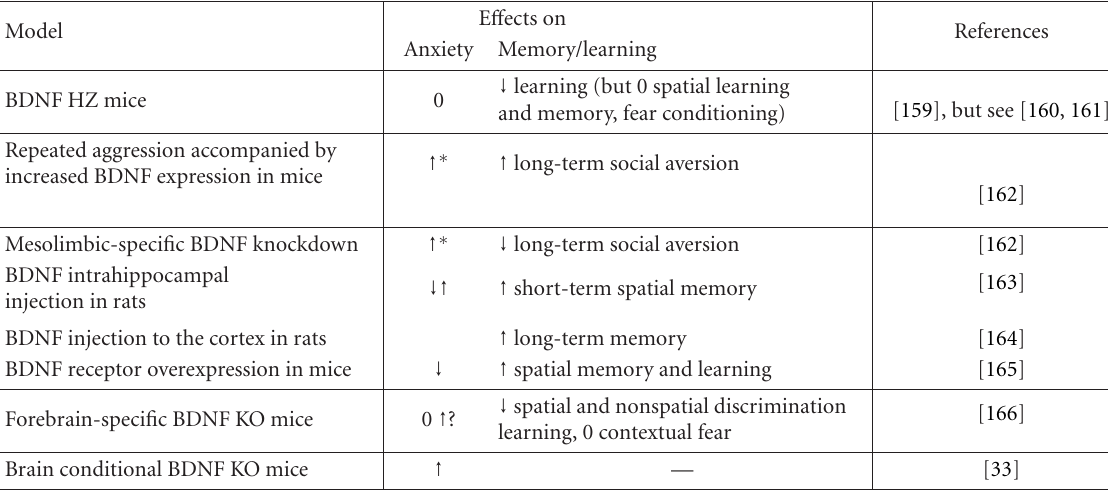
Table 3: Summary of data showing the role of BDNF in memory and anxiety. KO: knockout ( − / − ), HZ: heterozygous (+ / − ) mice. (?: unclear e ff ects. ∗ : although authors claimed that anxiety was unaltered in this study, it contradicts the original anxiogenic interpretation of the social defeat model (also see